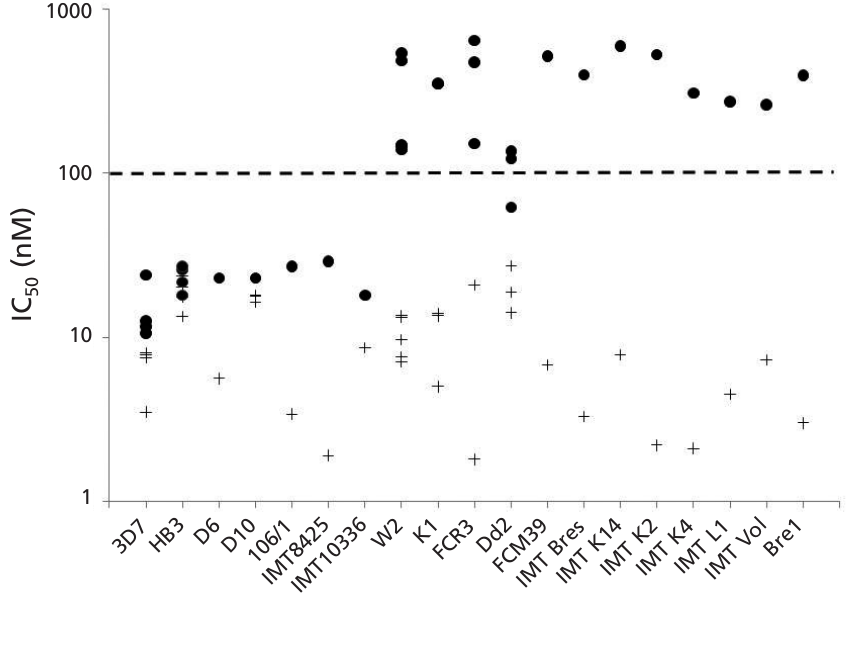
Fig 2. – Susceptibility of 19 laboratory P. falciparum clones to CQ and FQ compiled from 11 different published studies. IC for CQ for each clone tested ( l ). 50 + IC for FQ for each clone tested 50 ( + ). The doted line indicate the